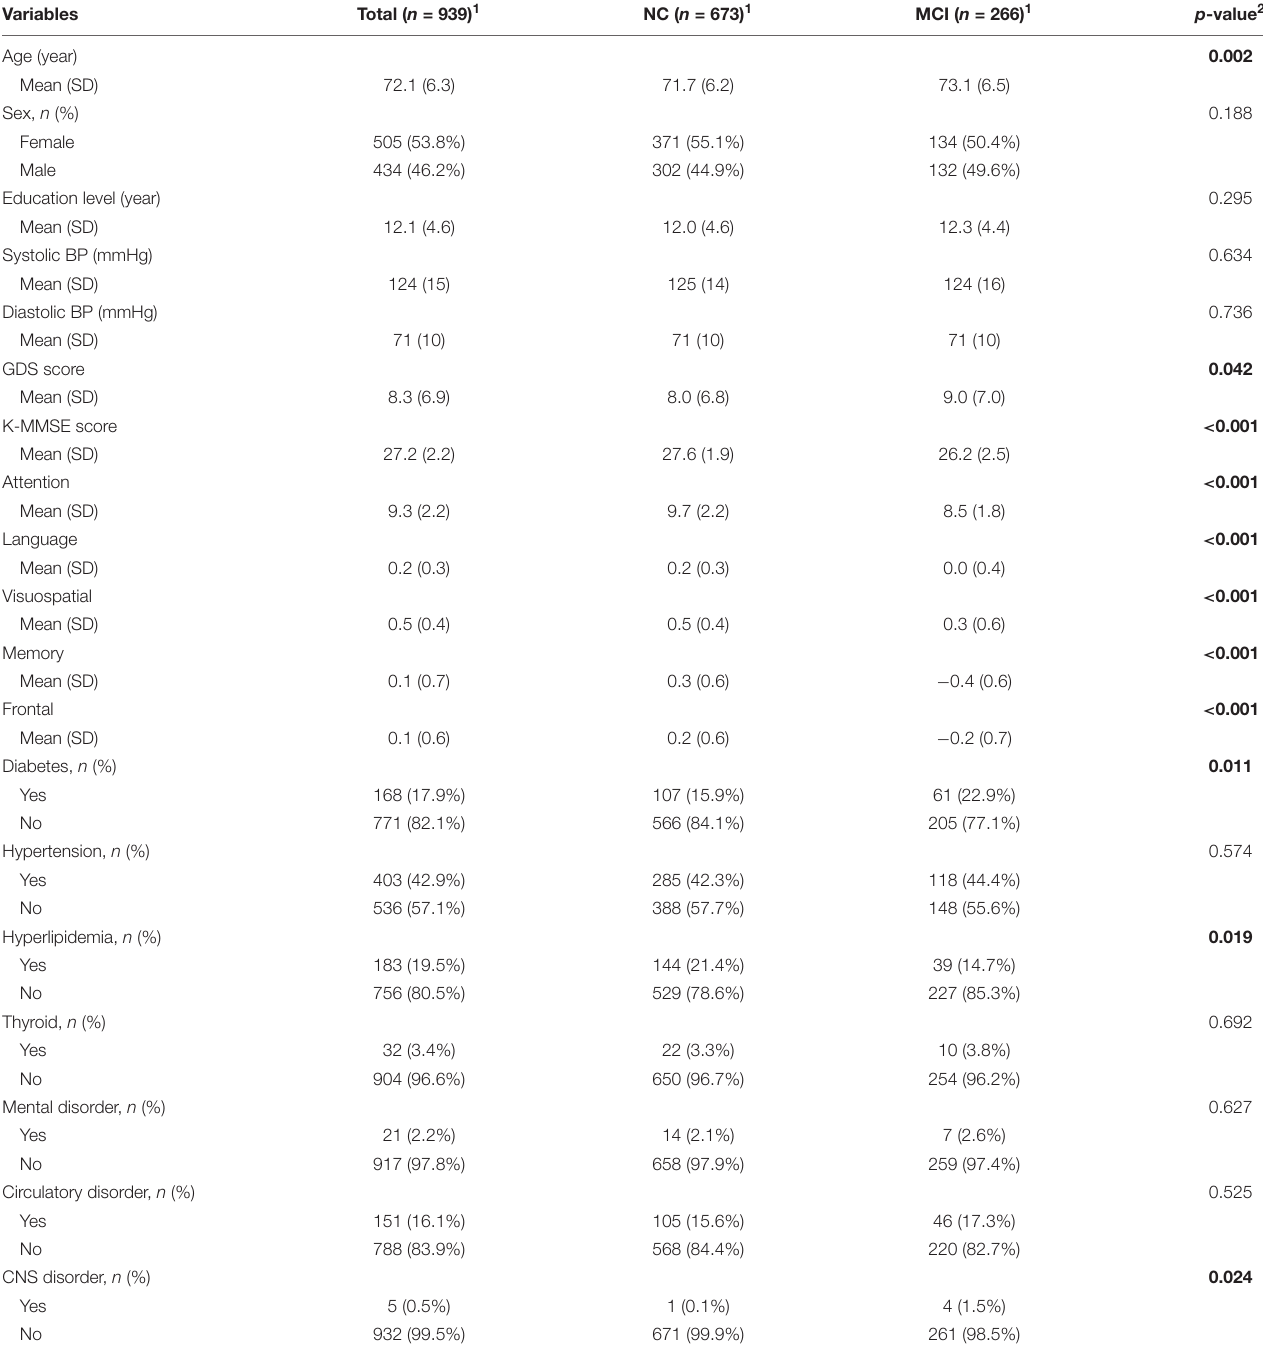
TABLE 1 | Demographic information and neuropsychological test results of MCI and CN